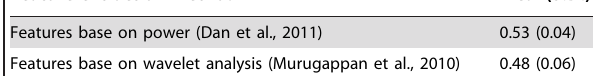
Feature extraction method Mean(S.D.)